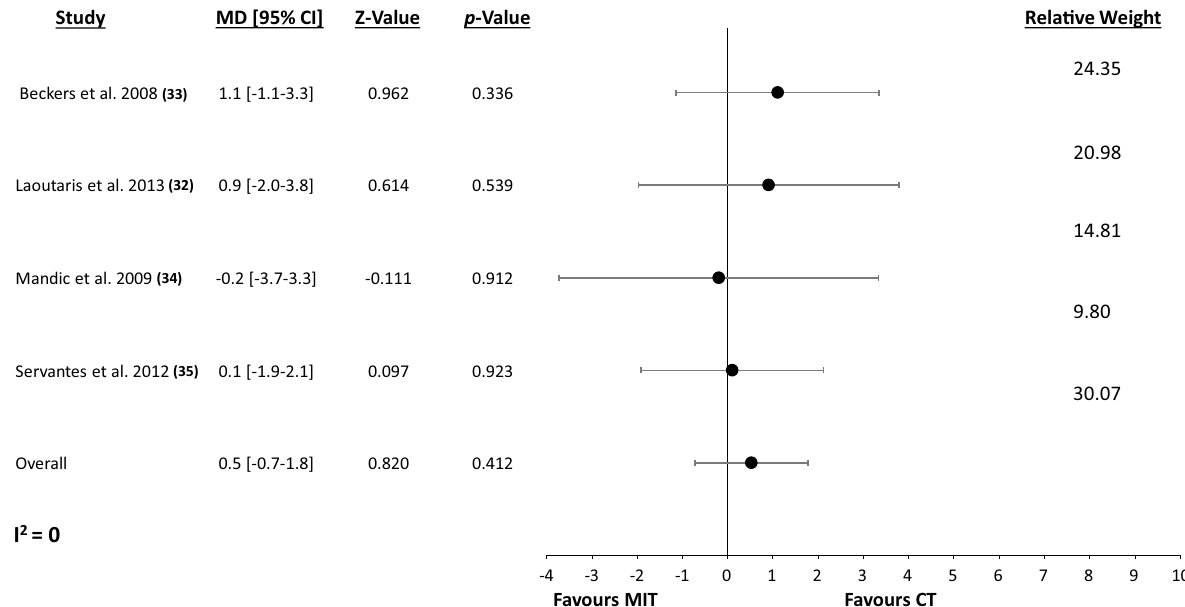
Fig. 2 Random-effects meta-analysis of the weighted mean difference in peak VO 2 between MIT and CT. MIT, Moderate intensity training; CT, combined training; MD, mean difference; VO2, peak oxygen uptake; IV, weighted mean